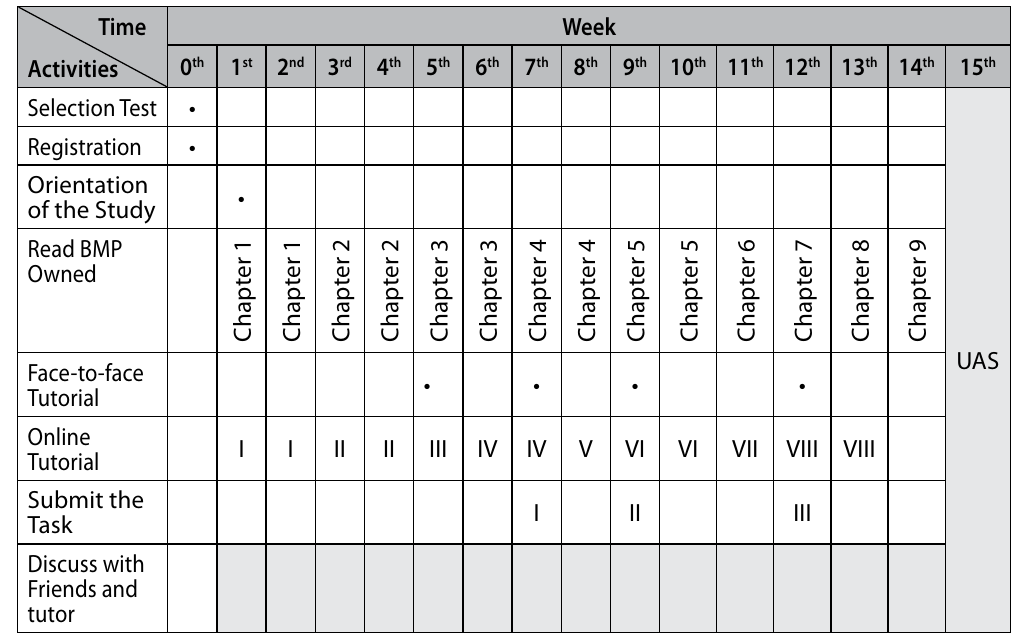
Table 4 Learning process of PPS student by